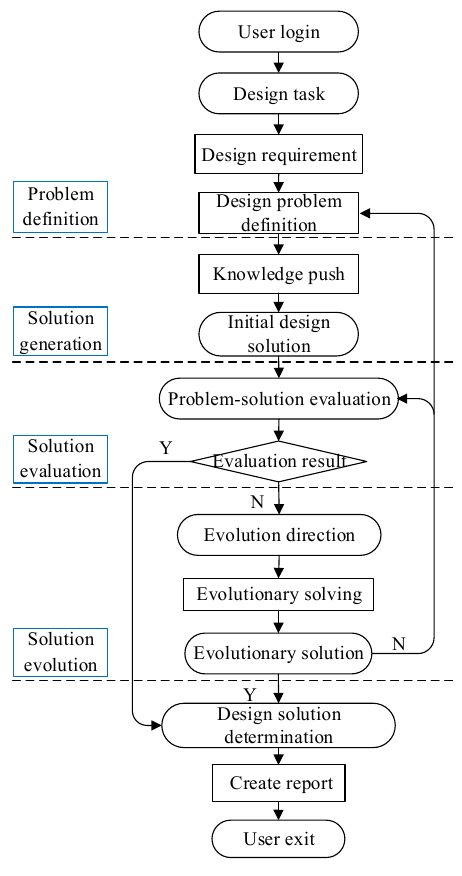
Figure 6. System operation flow.